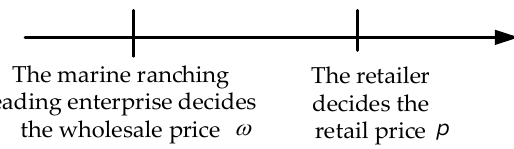
Figure 2. The game sequence of the leading enterprise and the retailer in Mode 1.